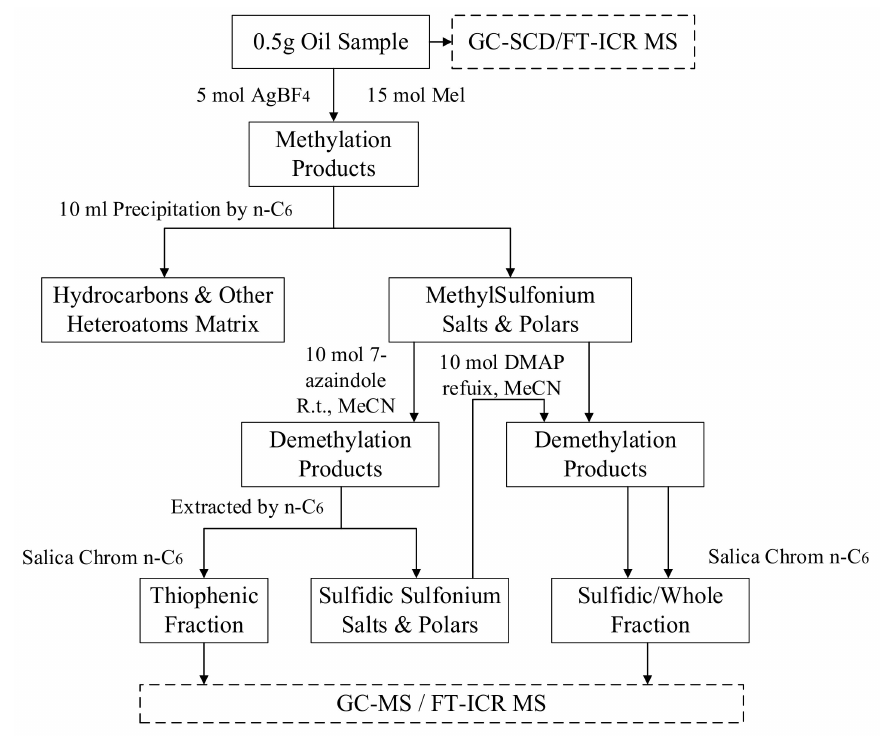
Figure 1. The experimental schematic